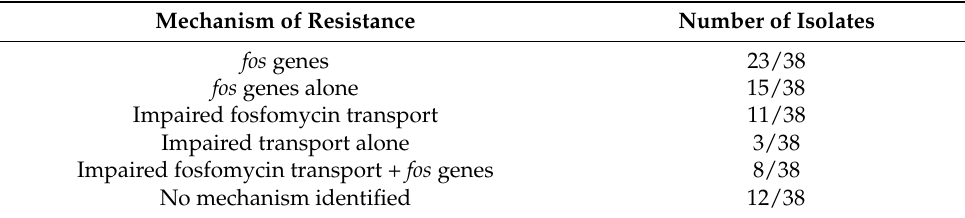
Table 2. Mechanisms of fosfomycin resistance identified in uropathogenic ESBL-producing E. coli